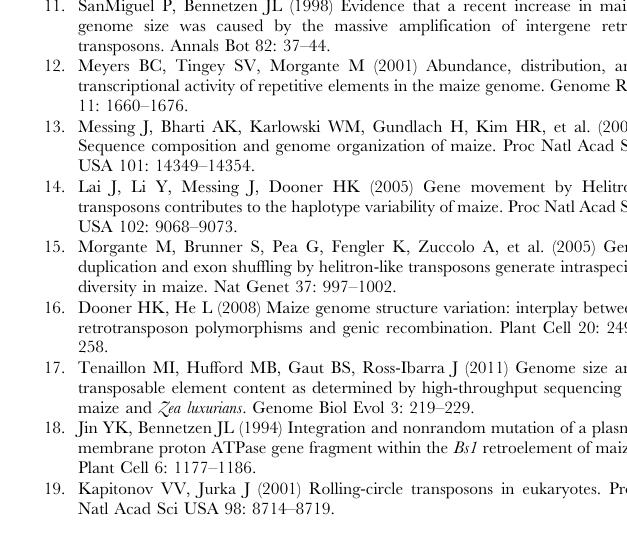
Table S9 Genes with unexpected expression patterns. a shows the number of RILs in which no read of the target gene was detected. b the number of RILs in which the target gene was expressed. c segregation rate was tested by using Chi-square test. d Genetic model was inferred according to the segregation rate. e I, U and S in column ‘‘Syntenic Code’’ represent the syntenic relationships among grass species: inserted, unknown and syntenic, respectively. f the classification of whole genome duplication.